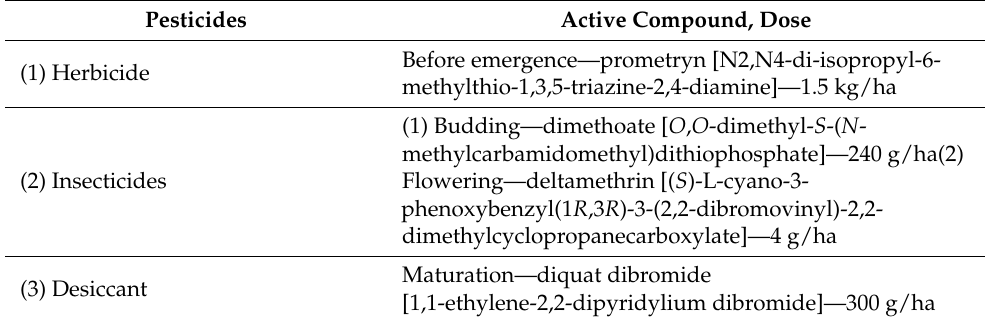
Table 2. Chemical plant protection system.